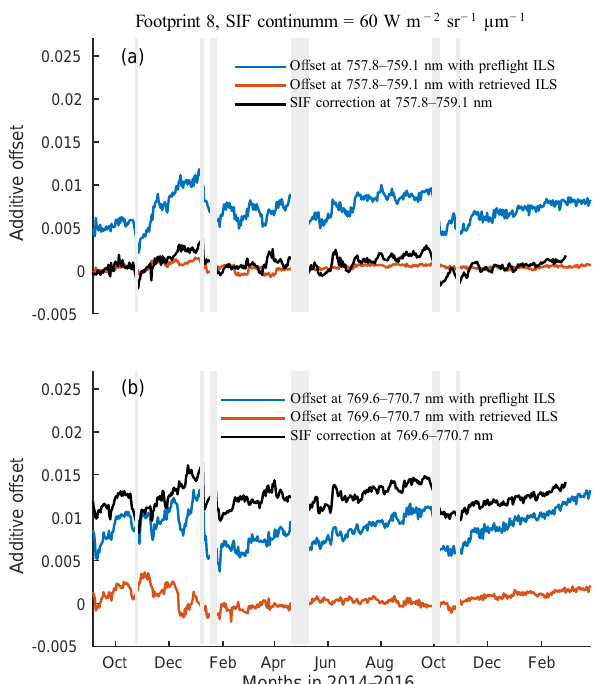
Figure 14. Retrieved offset from the earthshine spectra as a fraction of the continuum level in barren areas using preflight ILS (black); retrieved offset from solar spectra using preflight ILS (blue); and retrieved offset using solar-derived ILS through the stretch/sharpen fitting (red). The top and bottom panels show the SIF retrieval win- dows near 758 and 770nm, respectively. The gray bands show de- con